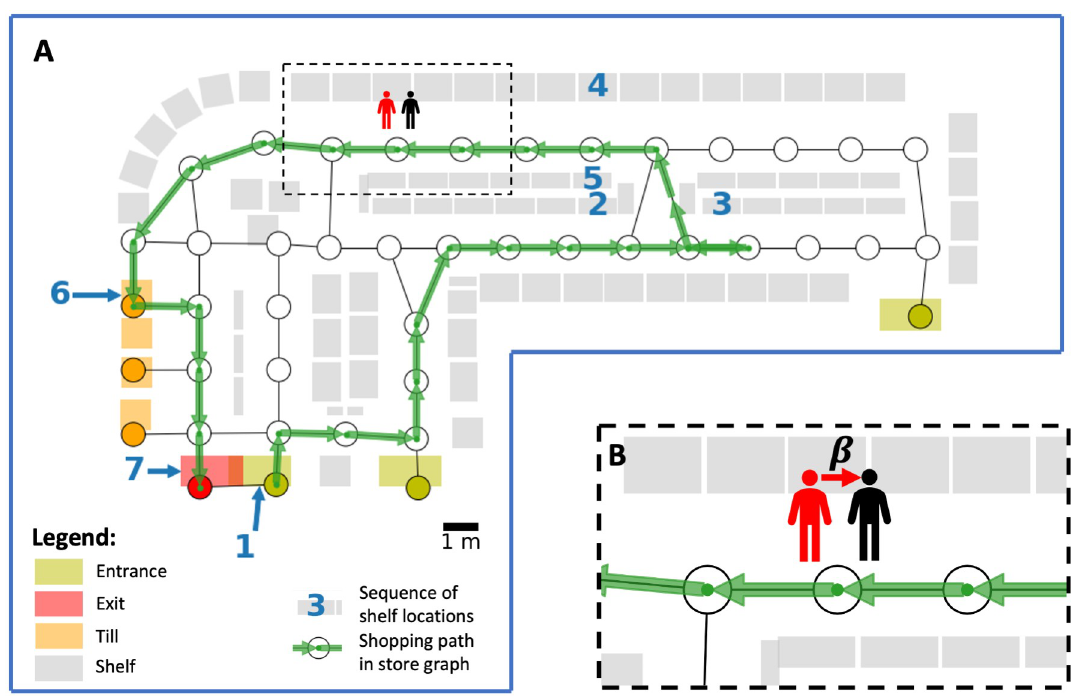
Fig 1. Overview of agent-based model. (A) A network representation of a small supermarket/convenience store with an example shopping path (in green). We generate each shopping path from a sequence of shelf locations (in blue), which correspond to the shelves from a customer picks up their items during a visit and the entrance and the tills. In this example, the customer picks up K = 4 items at the shelves marked in blue with 2, 3, 4, and 5. (B) Virus transmission model. A susceptible customer (in black) becomes infected at rate β whenever they are in the same zone as an infectious customer (in